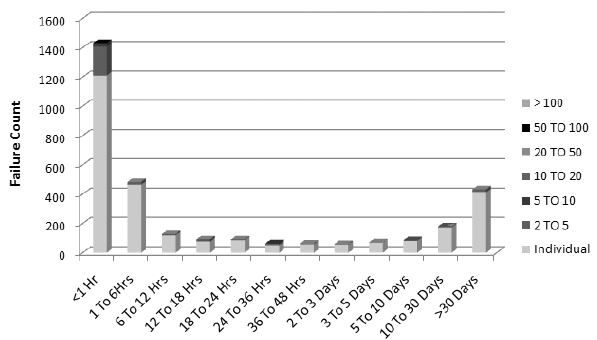
Figure 8. Weekday missing data events against hour of day.